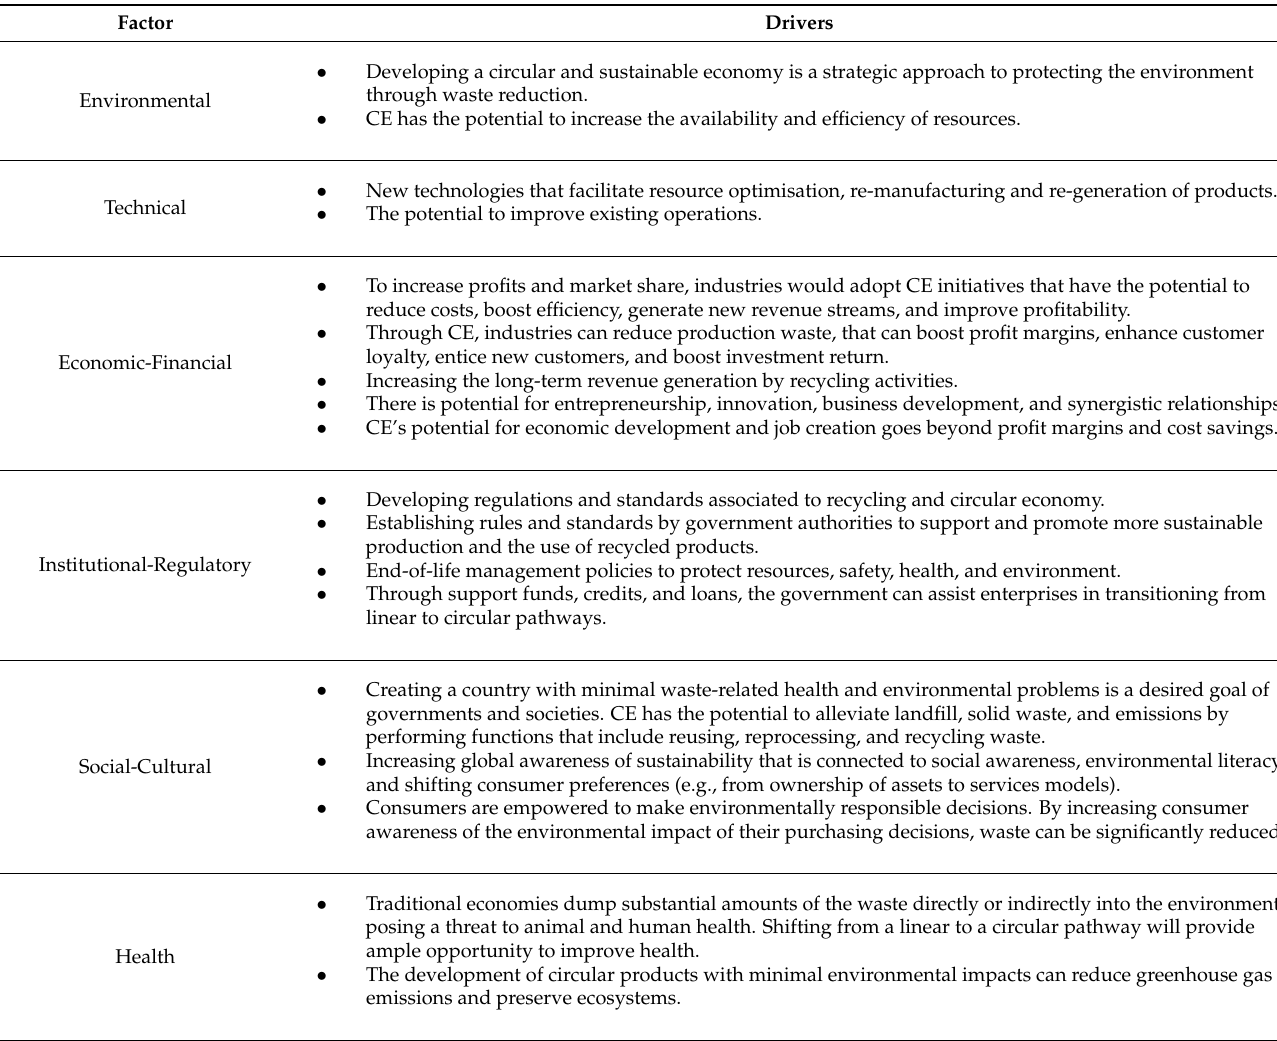
Table 2. CE drivers at global